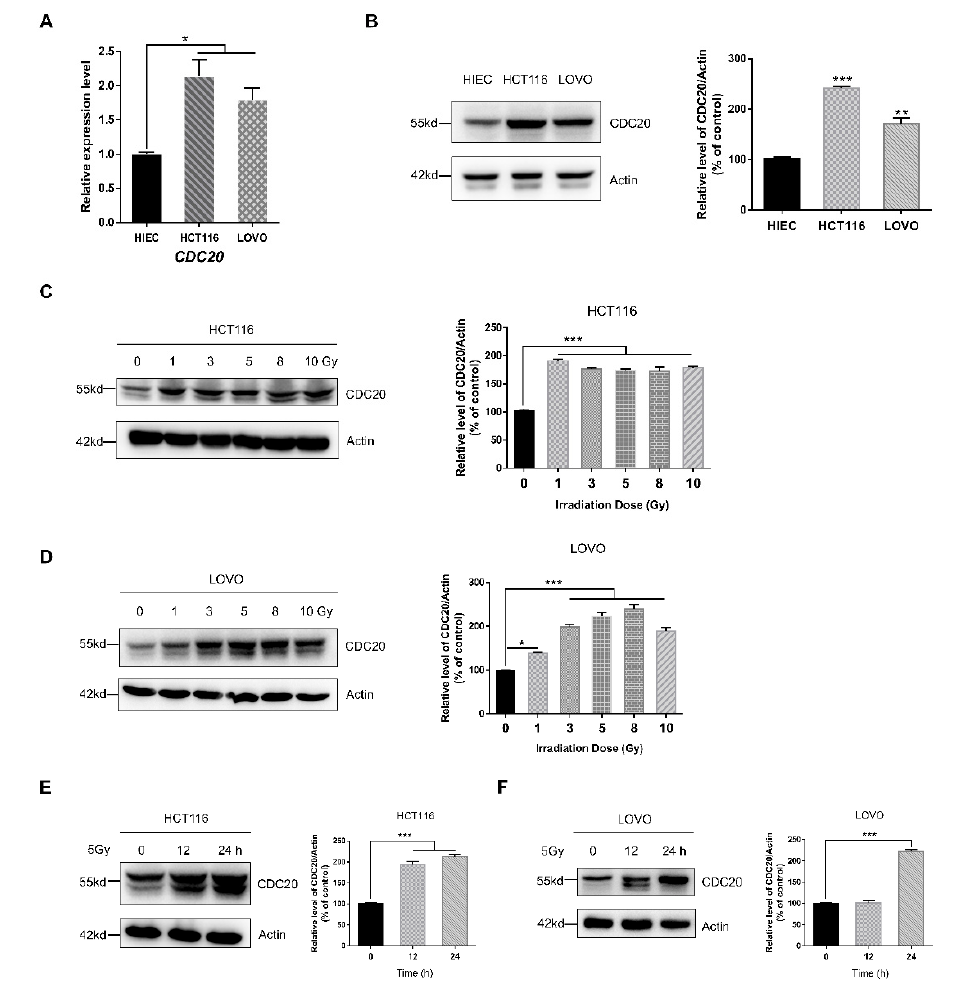
Figure 1. Cell division cycle 20 (CDC20) was overexpressed in human cancer cells and upregulated after radiation. ( A , B ) Transcriptional ( A ) and translational levels ( B ) of CDC20 in HIEC cells, HCT116 cells, and LOVO cells were detected by quantitative real-time PCR and immunoblotting. ( C , D ) HCT116 cells ( C ) and LOVO cells ( D ) were irradiated with di ff erent doses of γ -radiation, and the protein levels of CDC20 were analyzed by Western blotting 24 h later. ( E , F ) The expression of CDC20 in HCT116 cells ( E ) and LOVO cells ( F ) at di ff erent time points after 5 Gy γ -radiation. Actin was used as an internal control. Data were pooled from three independent experiments, and the results are represented as mean ± SD; * p < 0.05, ** p < 0.01, *** p < 0.001.